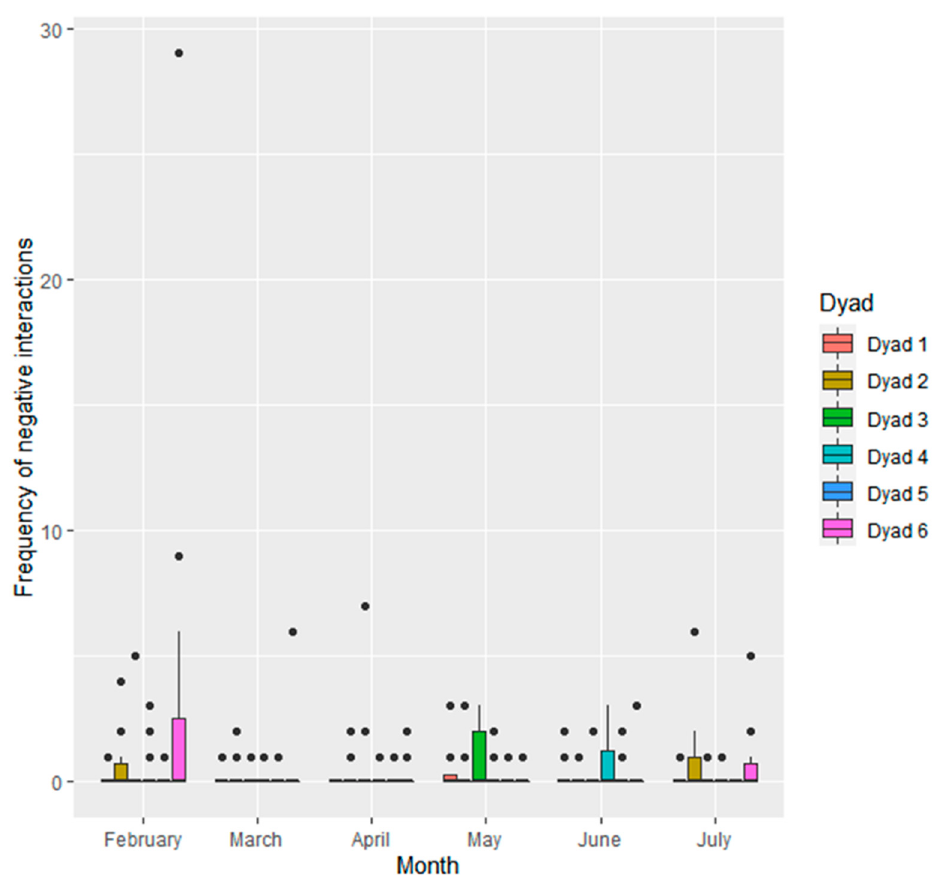
Figure 5. Frequency of negative social interactions given within each seal dyad ( n = 6; dyad 1: S1 and S2, dyad 2: S1 and S3, dyad 3: S1 and S4, dyad 4: S2 and S3, dyad 5: S2 and S4, dyad 6: S3 and S4) per observation period. Table 3. Average percentage of each observation period that seals were observed with others.